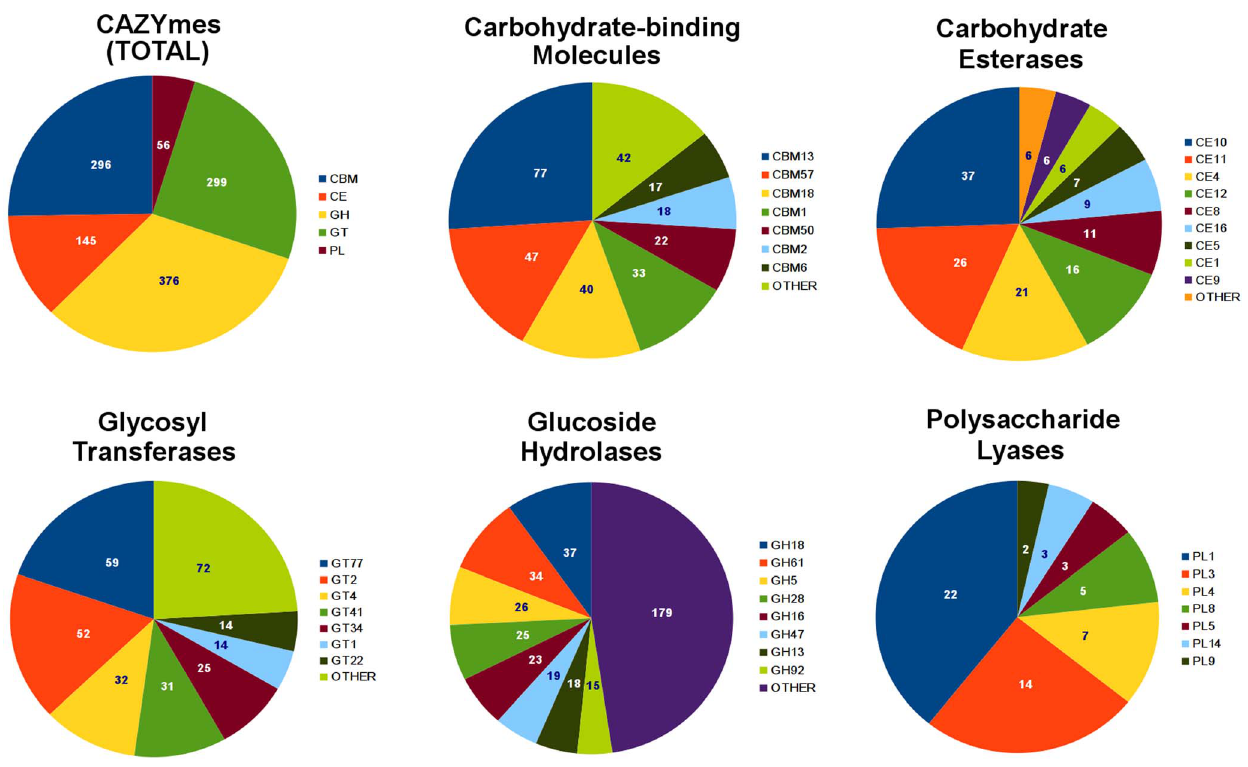
Figure 5. Summary of R.solani AG8 genes assigned with CAZyme functional annotations. An overall summary is presented for the 5 CAZyme categories: carbohydrate-binding molecules (CBMs), carbohydrate esterases (CEs), glycosyl transferases (GTs), glucoside hydrolases (GHs) and polysaccharide lyases (PLs). Individual summaries are also presented for each category, showing their most abundant CAZyme classes.